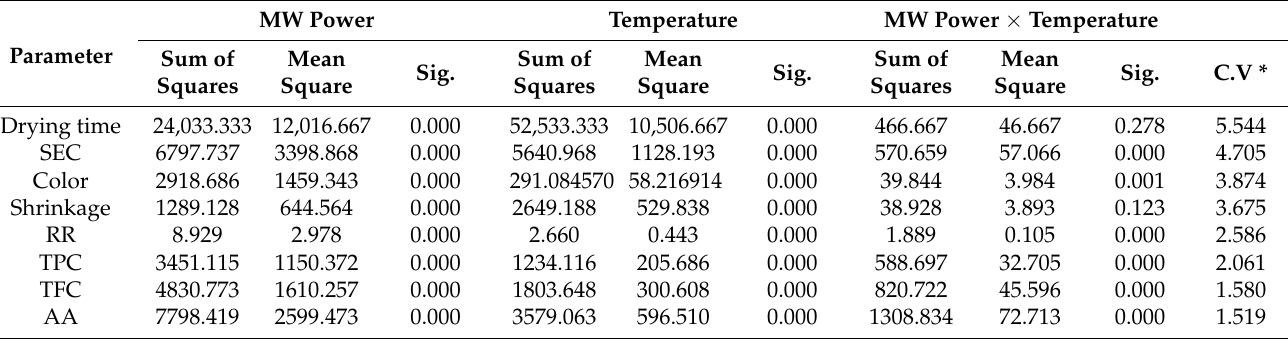
Table 2. ANOVA analysis results of the drying time, color, energy, shrinkage, RR, TPC, TFC and AA at different MW power, temperature and MW power